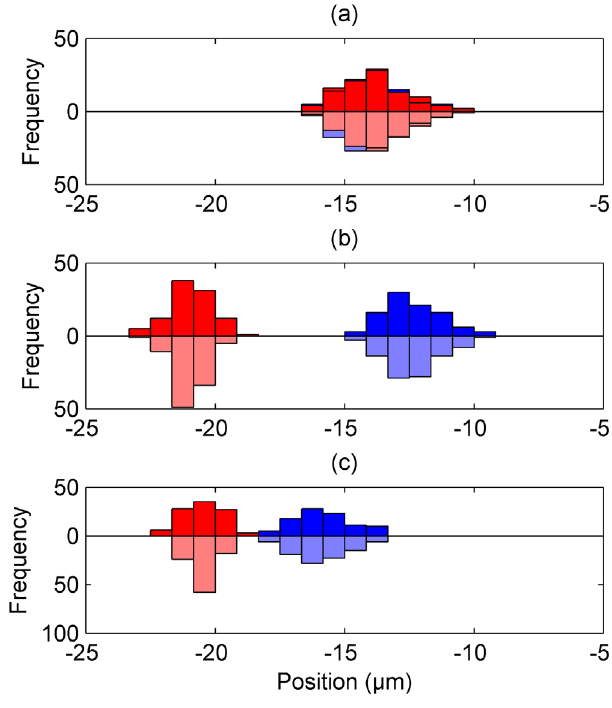
FIG. 17. Distributions of beam positions at MQF15X with feedback off (blue) and on (red) for (a) the first, (b) the second, and (c) the third bunches. The darker, positive bars show the measured positions; the lighter, negative bars show the positions measured at P2 and P3 propagated to MQF15X. The mean propagated positions have been adjusted to match those of the respective measurements, as the beam propagation model does not take the actual BPM positions into